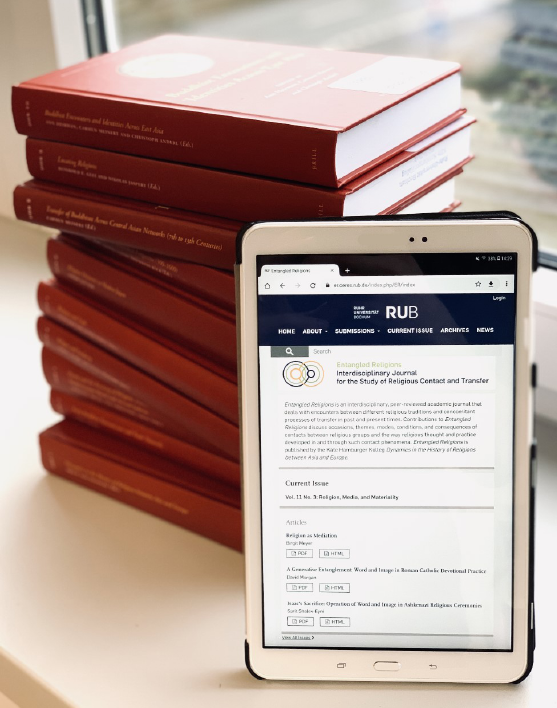
Figure 5 Books from the KHK series “Dynamics in the History of Religions” and the Entangled Reli- gions